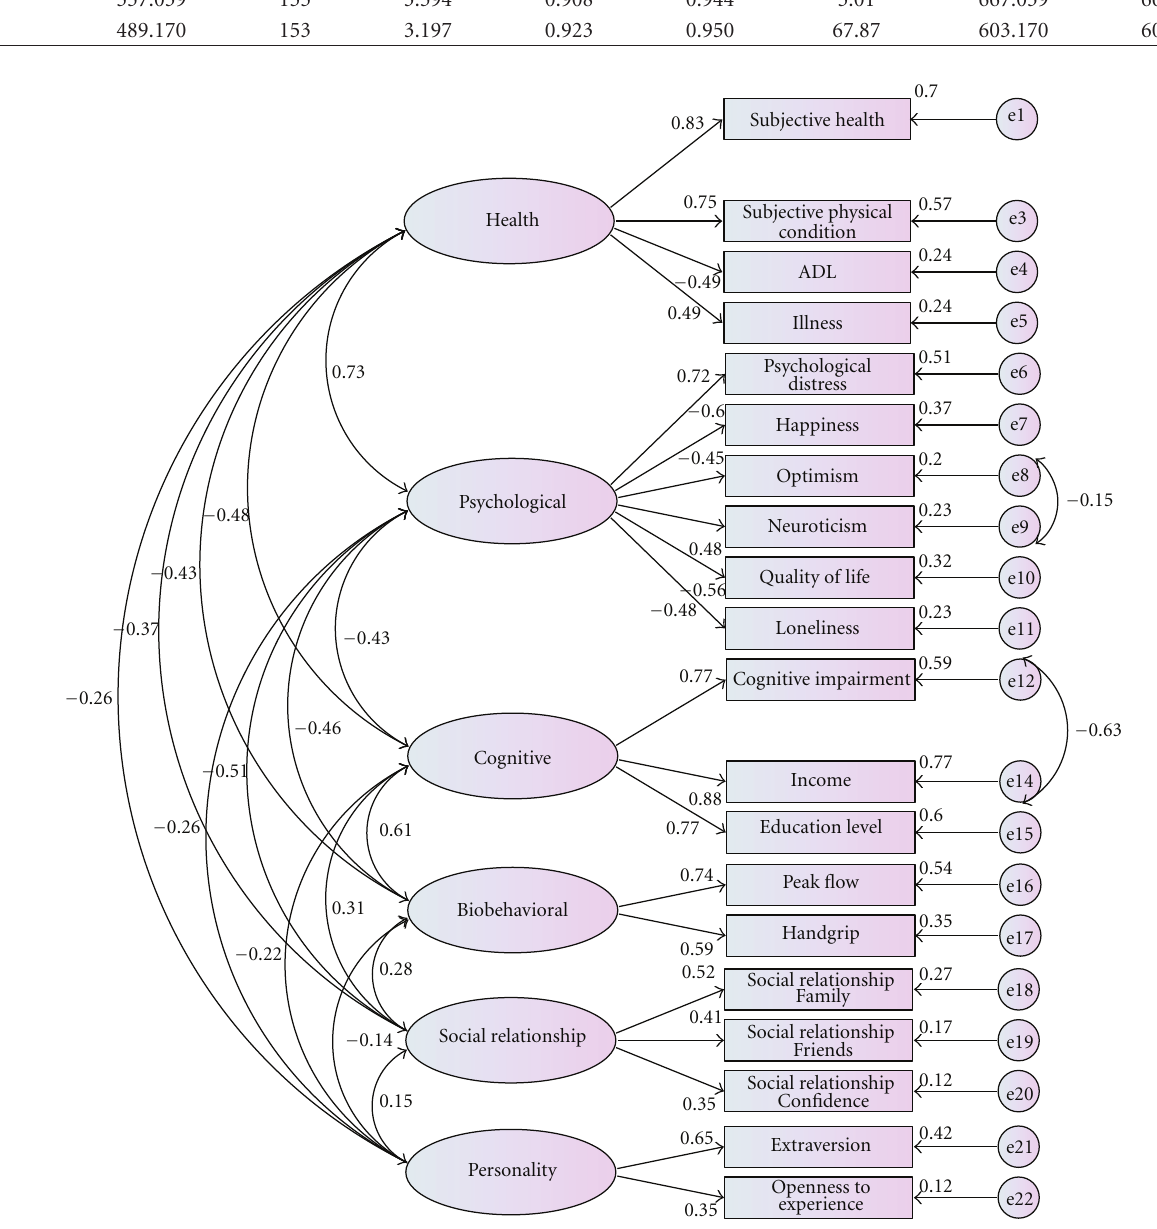
Figure 2: Factor structure model for